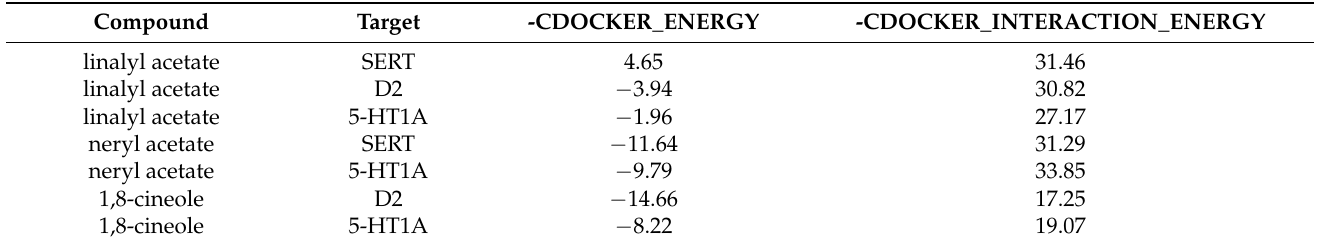
Table 7. Molecular docking predictions of interactions between molecular targets in depression, natural compounds linalyl acetate, neryl acetate, and 1,8-cineole and CDOCKER scores calculated for analyzed ligands. Compound Target -CDOCKER_ENERGY linalyl